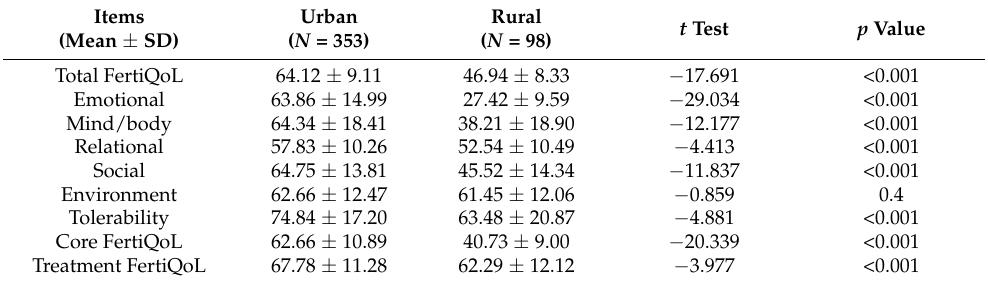
Table 4. Characteristics of average indicators of FertiQoL by place of residence.